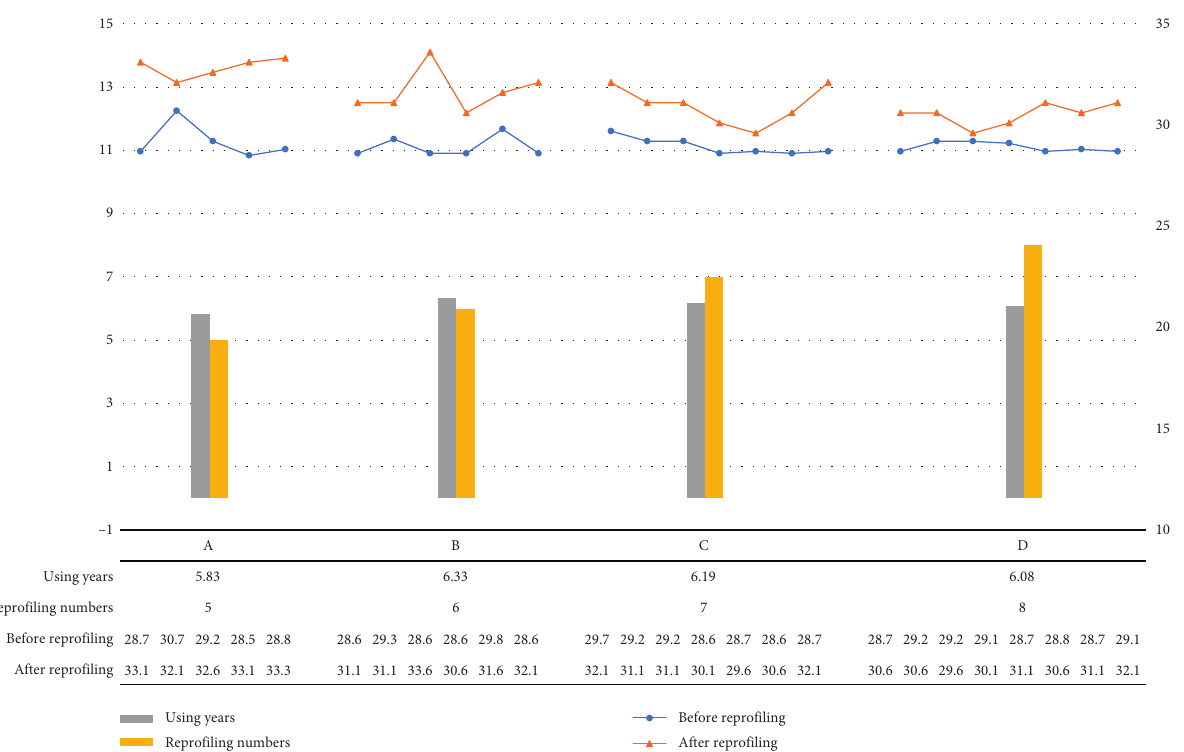
Figure 10: Random generated strategy.